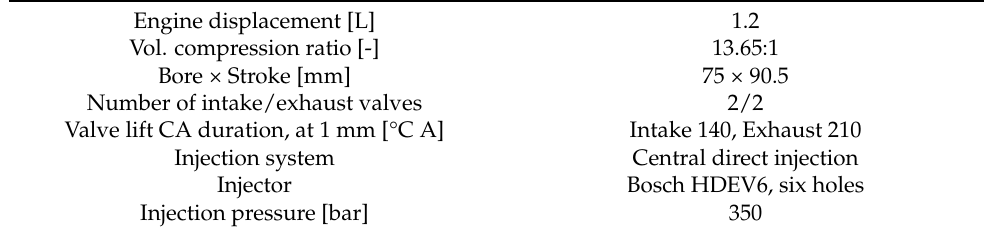
Table 1. Multi-cylinder engine main features.